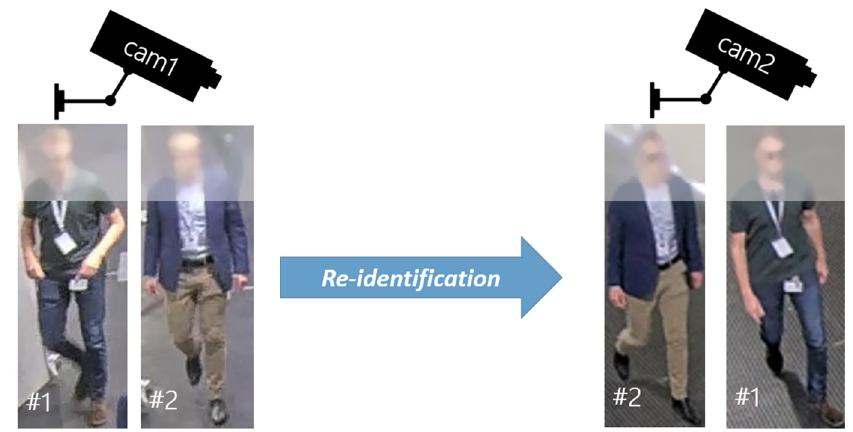
Figure 2. Person re ‐ identification with anonymized